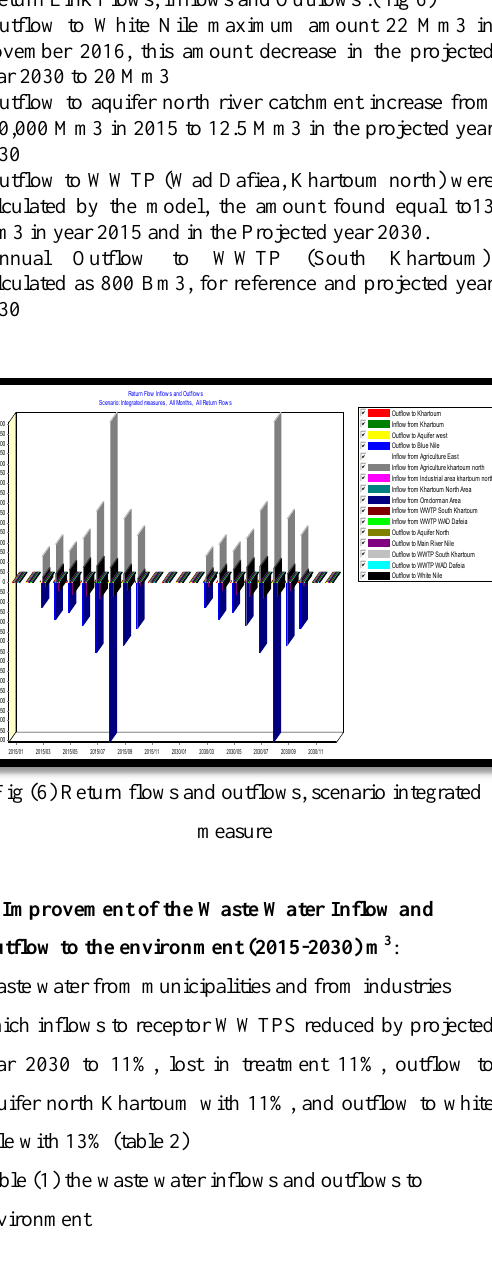
Fig (5) Model Schematic Area (Sector Demands &Supplies